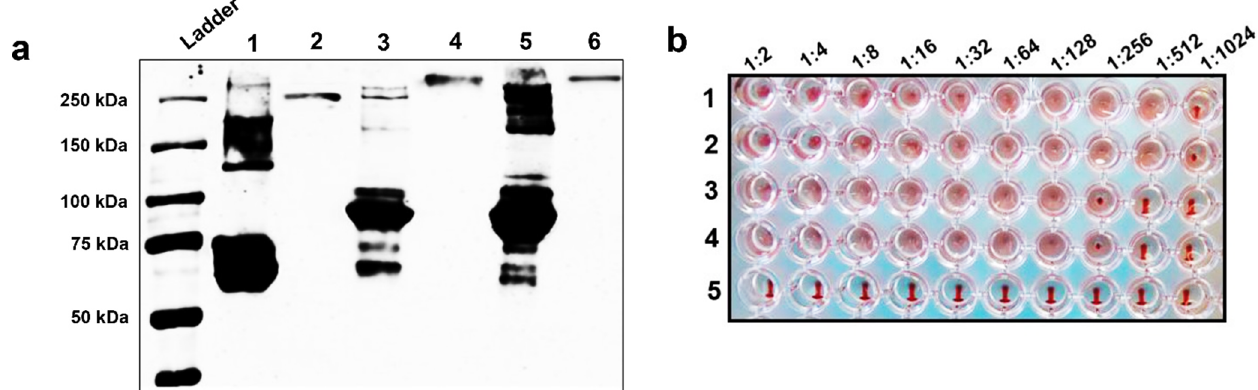
Figure 2. BS3 crosslinking experiment and haemagglutination assay to determine the oligomeric form and activity of recombinant H9HA ectodomain with foldon respectively ( a ) BS3 crosslinking experiment. Lane 1: rH9HA without BS3; Lane 2: rH9HA with 10 mM BS3; Lane 3: rH9HA-Dec205 scFv without BS3; Lane 4: rH9HA-Dec205 scFv with 10 mM BS3; Lane 5: rH9HA-CD11c scFv without BS3; Lane 6: rH9HA-CD11c scFv with 10 mM BS3. About 15 μ g of the recombinant protein was mixed with BS3 to a 10 mM final concentration and incubated for 1 h at room temperature. The cross-linking reaction was stopped by the addition of 1 M Tris-HCl pH 8.0 to a final concentration of 50 mM and incubated for 15 min at room temperature. After cross-linking, proteins were separated on 8% SDS-PAGE under reducing conditions, blotted and immunodetected using anti-H9HA monoclonal antibody. ( b ) Haemagglutination assay to test the activity of recombinant H9HA with foldon. 1. UDL 01/08 H9N2 virus; 2. rH9HA; 3. rH9HA-Dec205 scFv; 4. rH9HA-CD11c scFv; 5. Negative control (PBS). For haemagglutination assay, a two-fold serial dilution of 35 μ g of the recombinant HA proteins was carried out in 96-well plates. 50 μ L of 1% chicken RBCs was added. The plates were incubated at 4 °C for one hour and the highest dilution of the protein causing the agglutination of the RBCs was noted.